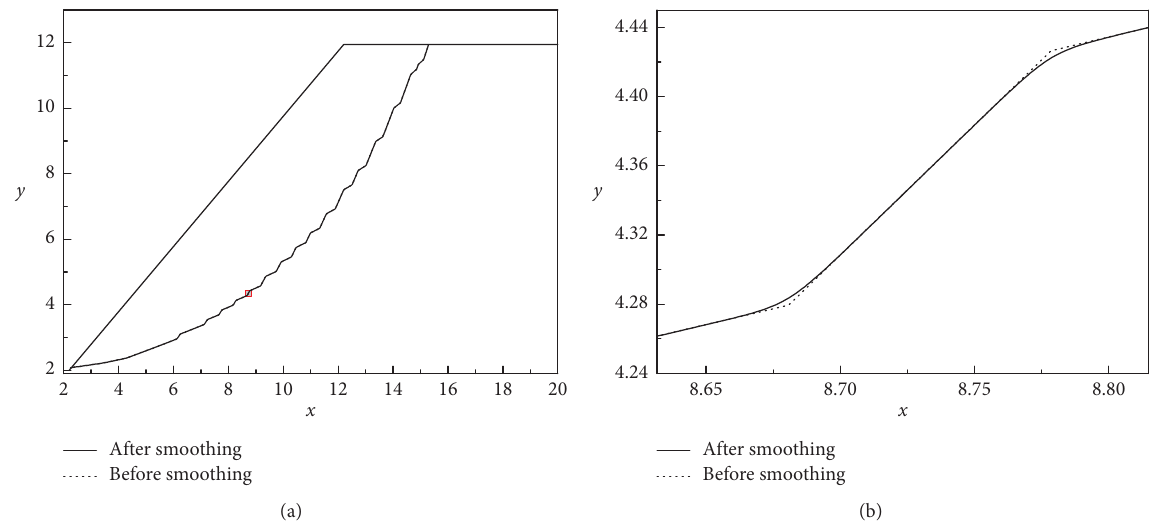
Figure 15: Slope slip surface curve comparison